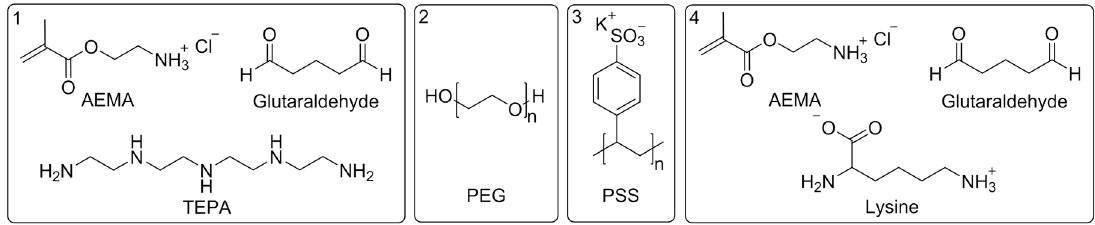
Figure 2. Modification reagents for ( 1 ) polyvinylidene fluoride-tetraethylenepentamine (PVDF-TEPA); ( 2 ) PVDF-polyethylene glycol (PVDF-PEG); ( 3 ) PVDF-polystyrene sulfonate (PVDF-PSS); and ( 4 ) PVDF-Lysine.